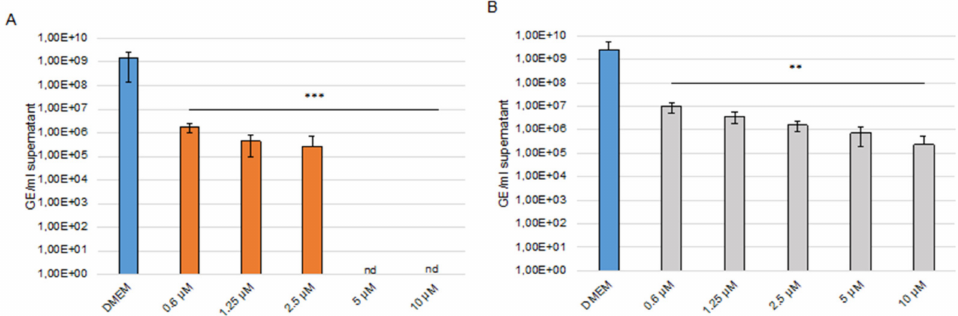
Figure 9. Effects of the high-sulfated GAGs on SARS-CoV-2 replication. Caco-2 cells were